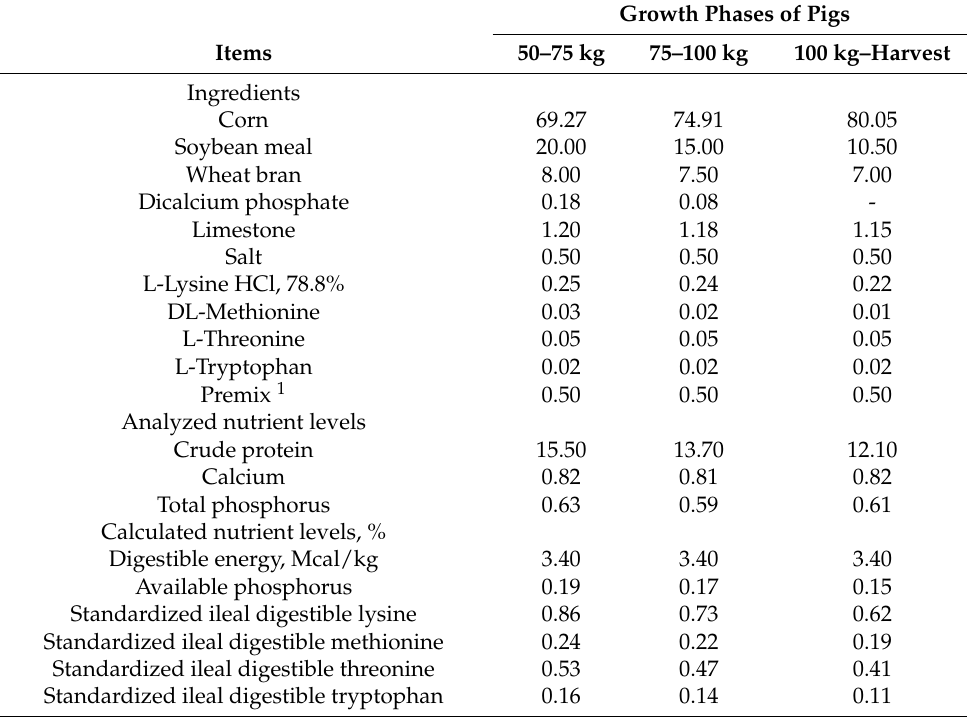
Table 1. Dietary formulation and analyzed or calculated nutrient levels (%) for each